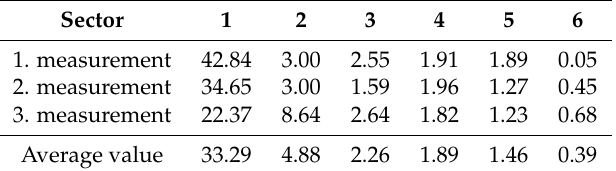
Table 3. Average values of the oil film areal density (in g/m 2 ) in a 35-mm slim pipe. The section length is 1 m. The total measured pipe length is 6